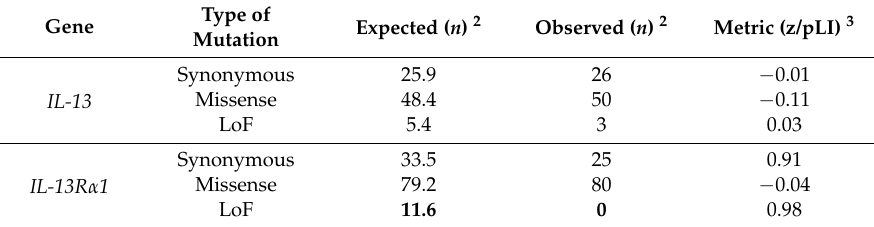
Global counter-selection against mutations in key genes affecting interleukin 13 (IL-13) signaling.